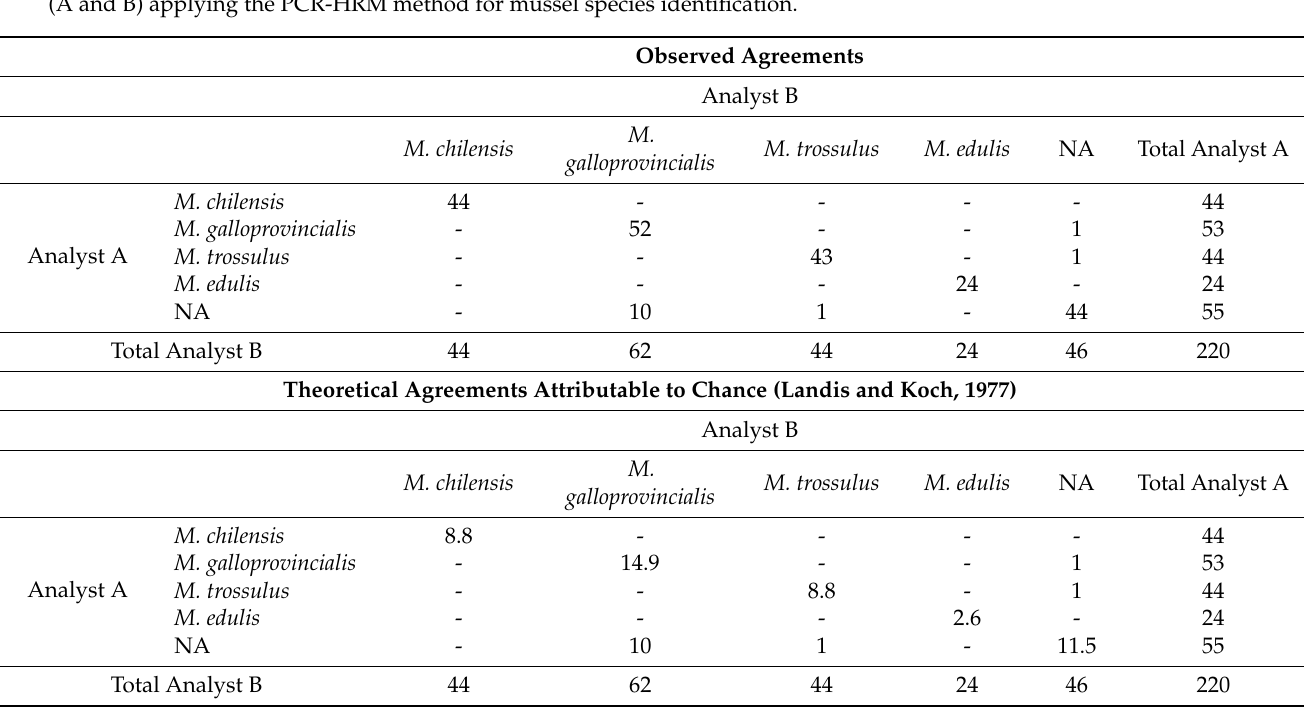
Table 9. Observed and theoretical agreement analysis to evaluate the concordance between the results from two laboratories (A and B) applying the PCR-HRM method for mussel species